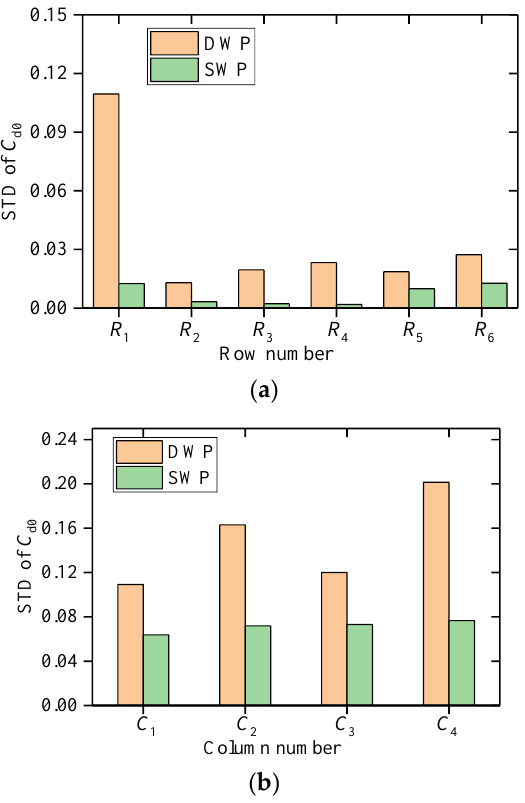
Figure 20. Comparisons of STD between DWP and SWP of C d 0 ( a ) for each row and ( b ) for each column.